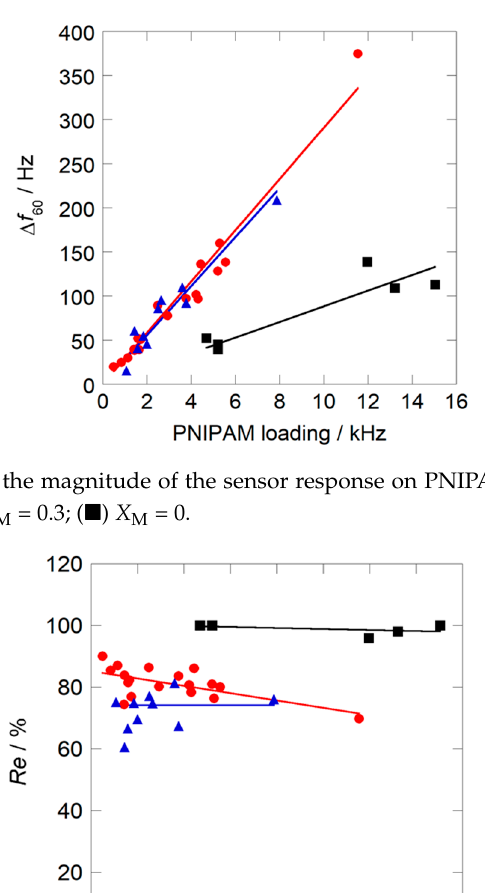
Figure 6. Dependence of the magnitude of the sensor response on PNIPAM loadings measured at 30 °C: ( ● ) X M = 0.2; ( ▲ ) X M = 0.3; ( ■ ) X M = 0.